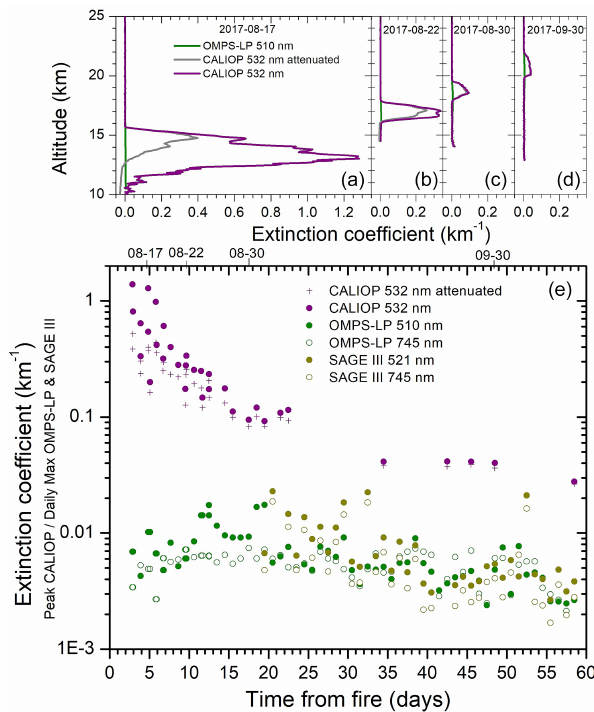
Figure 7. Extinction coefficients according to CALIOP, OMPS- LP, and SAGE III/ISS in the 20–80 ◦ N latitude range during the first 60d following the North American fire. (a–d) Selected profiles (attenuated and corrected for attenuation) from CALIOP compared with closest profiles according to OMPS-LP. (e) Peak extinction co- efficient from selected CALIOP profiles compared with daily max- imum extinction coefficients from OMPS-LP and SAGE III/ISS. Note that SAGE III/ISS data are missing the first 19d because of irregular coverage of the latitude range of